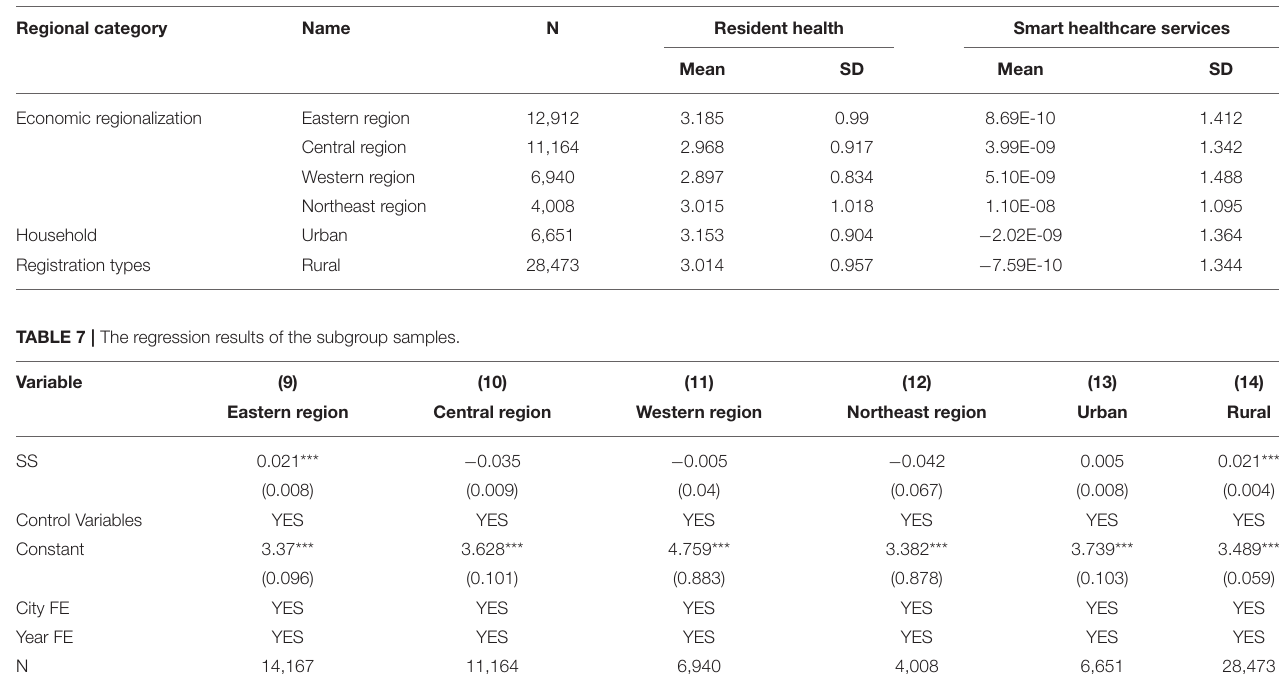
TABLE 6 | The descriptive statistics of subgroup samples.